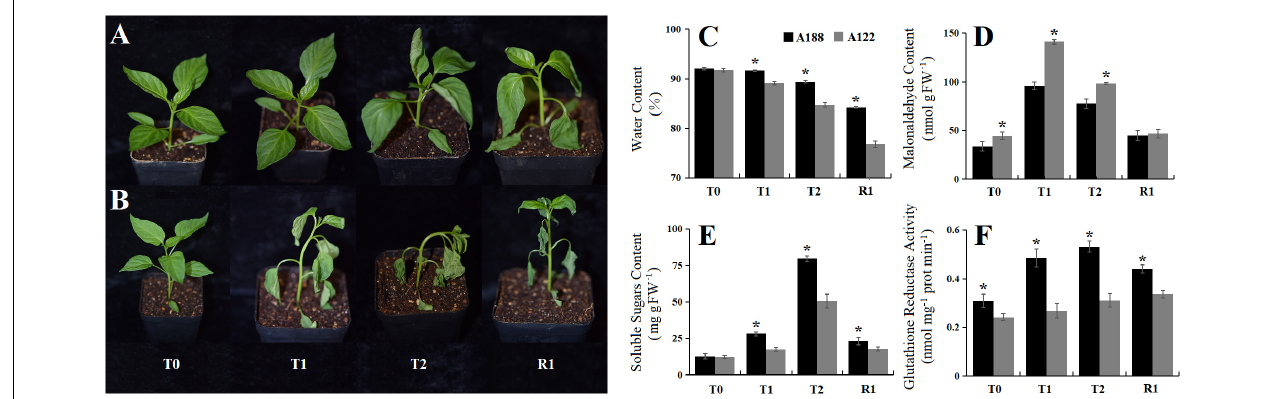
FIGURE 1 | Phenotypic and physiological response of A188 (cold-resistant variety) and A122 (cold-sensitive variety) under cold stress and recovery stages. (A) Phenotype of cold-resistant A188 under different treatments. (B) Phenotype of cold-sensitive A122 under different treatments. (C) Changes in relative water content in the pepper leaves. (D) Changes in malondialdehyde content in the pepper leaves. (E) Changes in total soluble sugar contents in the pepper leaves. (F) Changes in glutathione reductase activity in the pepper leaves. T0, T1, T2, and R1 refer to 0 h, 2 h, 12 h of cold stress, and recovery 1 h after 72 h of cold stress treatment, respectively. The black and gray columns in the bar chart represent A188 and A122, respectively. The symbol * indicates a significant difference between A188 and A122 in the same treatment ( P < 0.05).